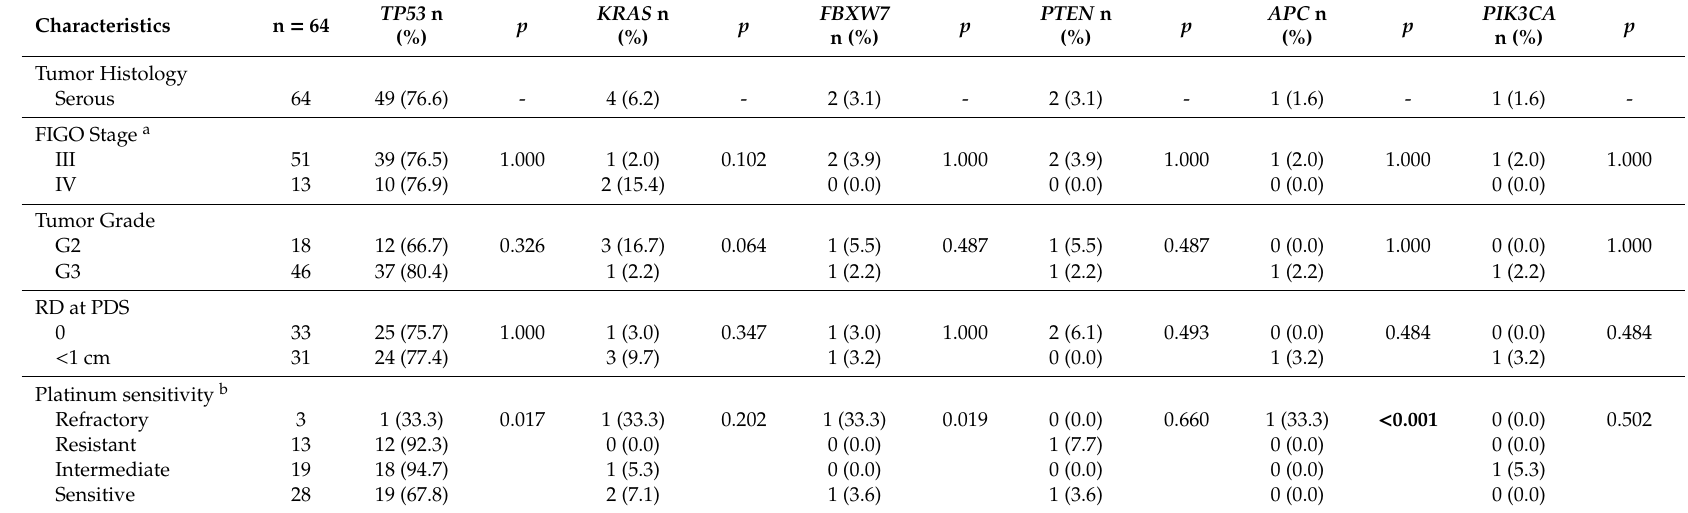
Table 2. Distribution of somatic mutations (presence vs. absence) detected by NGS according to clinico-pathologic characteristics of patients with